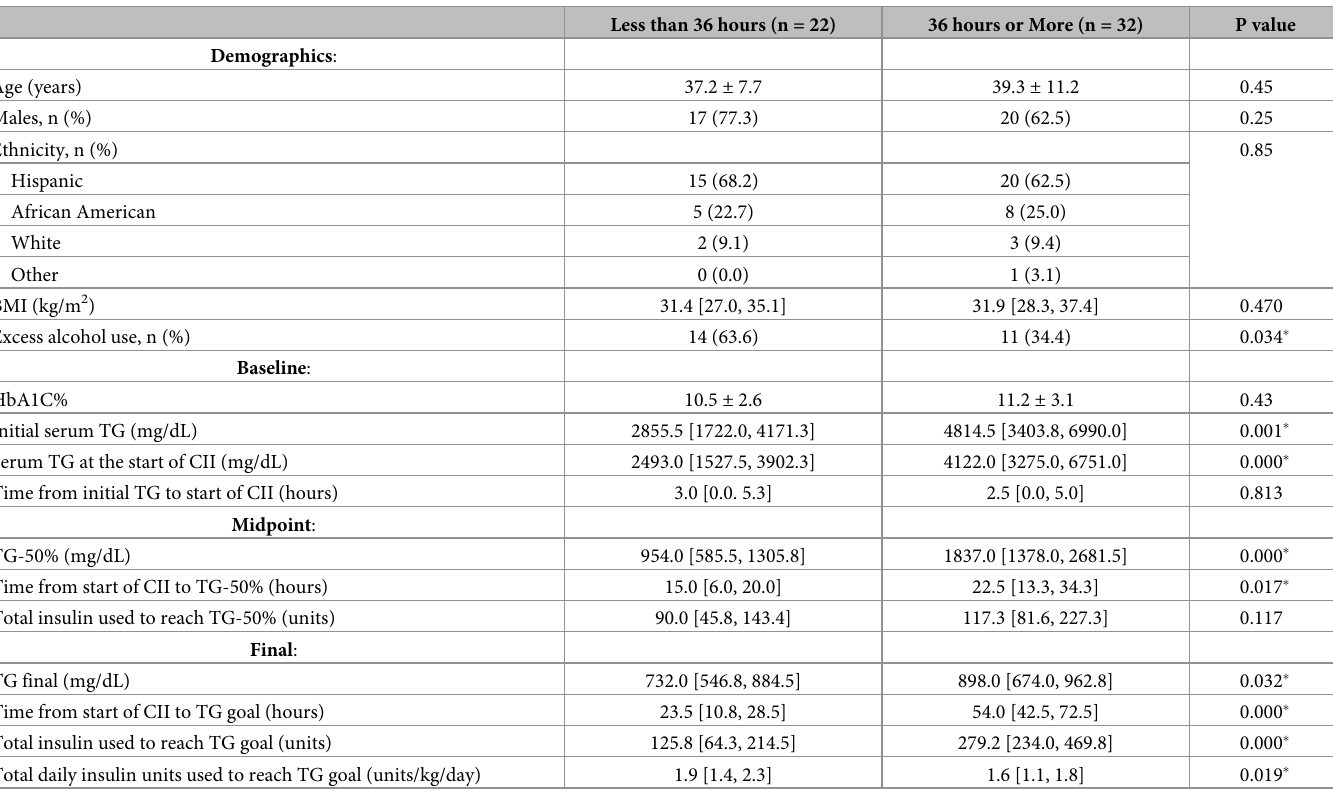
Table 4. Clinical and laboratory characteristics among the 54 patients with diabetes in the responder group who reached TG goal in less than 36 hours vs 36 hours or